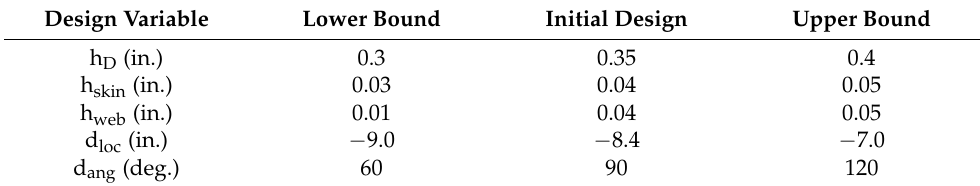
Table 3. Initial value and design range in design variable.